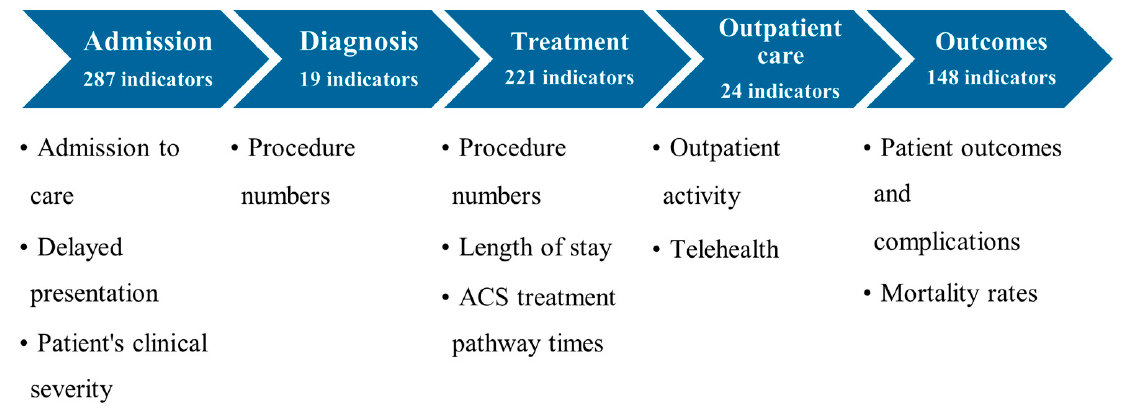
Figure 2. Countries reported on in the included articles (including articles reporting on multiple countries), color-graded according to the number of included papers (n = 109).